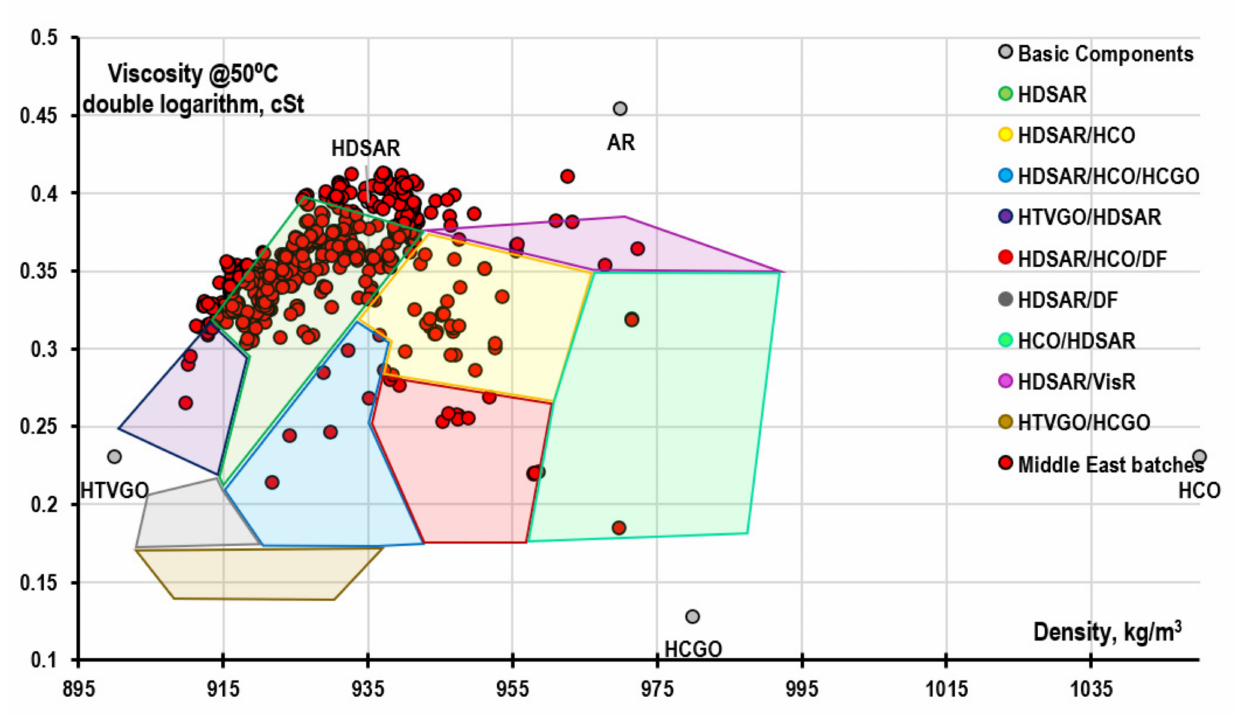
Figure 20. Lots of ports in the Middle East in logarithmic coordinates